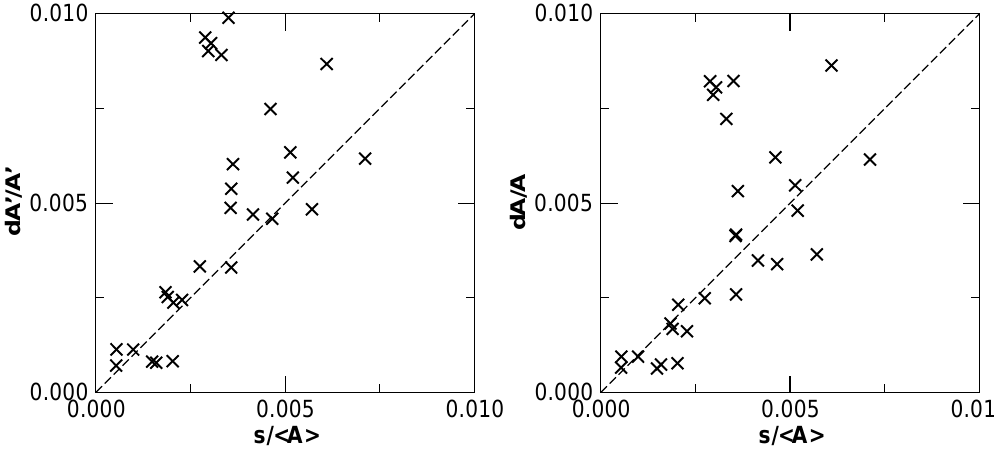
Figure 1. Left panel shows (cid:14)A ′ =A ′ vs s= (cid:22) A and right panel shows (cid:14)A=A vs s= (cid:22) A for 28 LS -allowed E1 transitions in O IV. Transition rates are taken from [21]. See text for